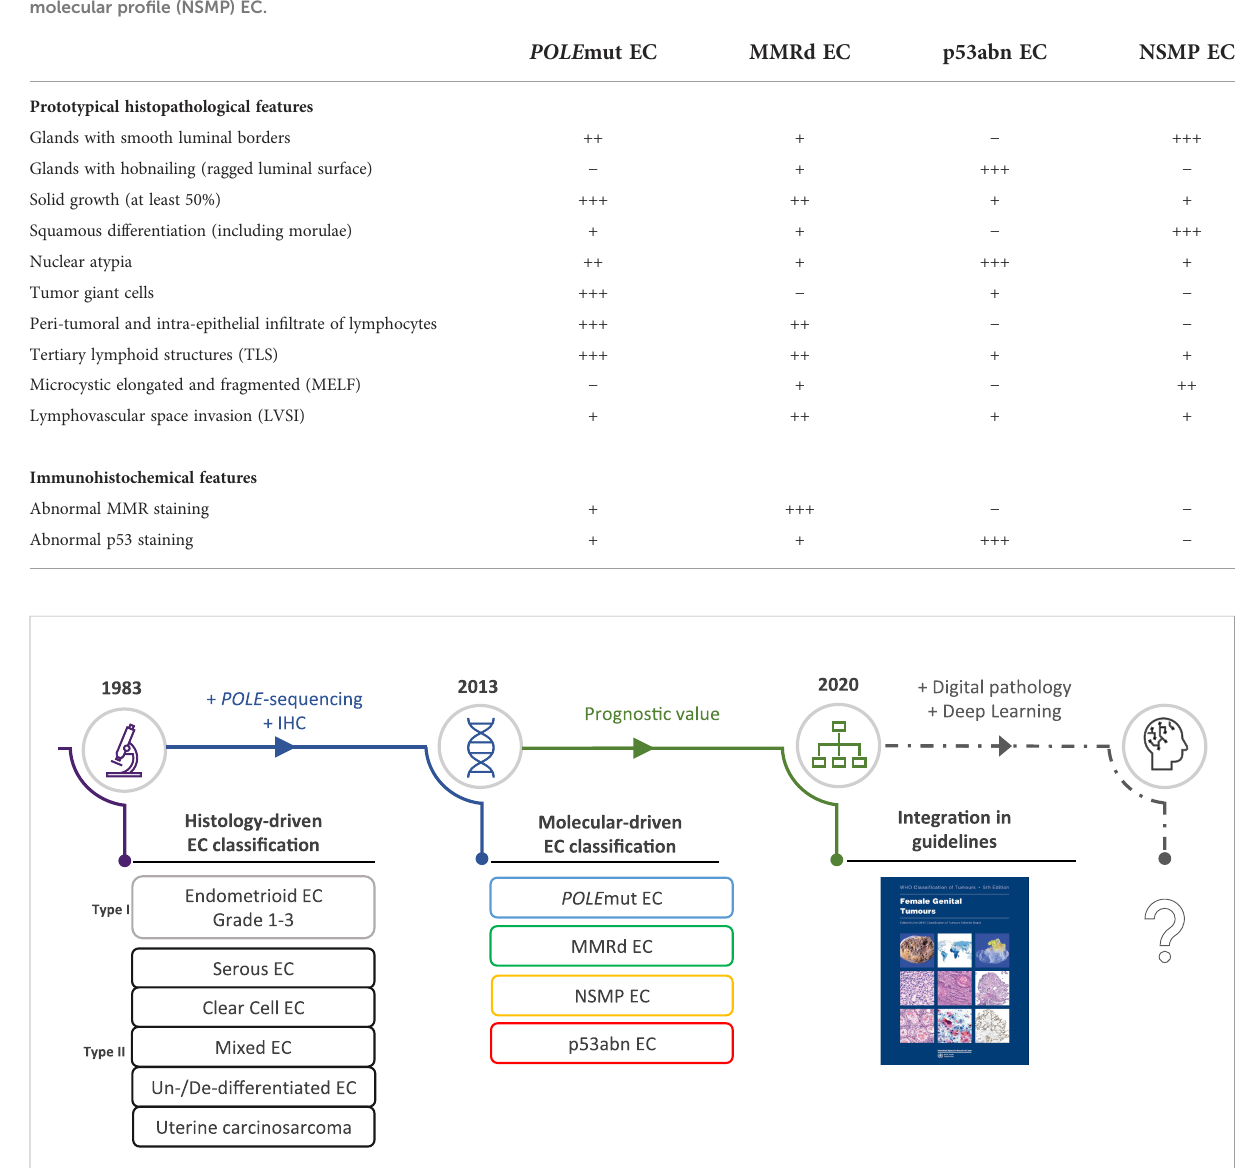
TABLE 1 Summary of the histopathological and immunohistochemical features correlated with the molecular endometrial cancer (EC) classi fi cation, dividing EC into POLE -mutated ( POLE mut) EC, mismatch repair de fi cient (MMRd) EC, p53 abnormal (p53abn) EC, and non-speci fi c molecular pro fi le (NSMP) EC.